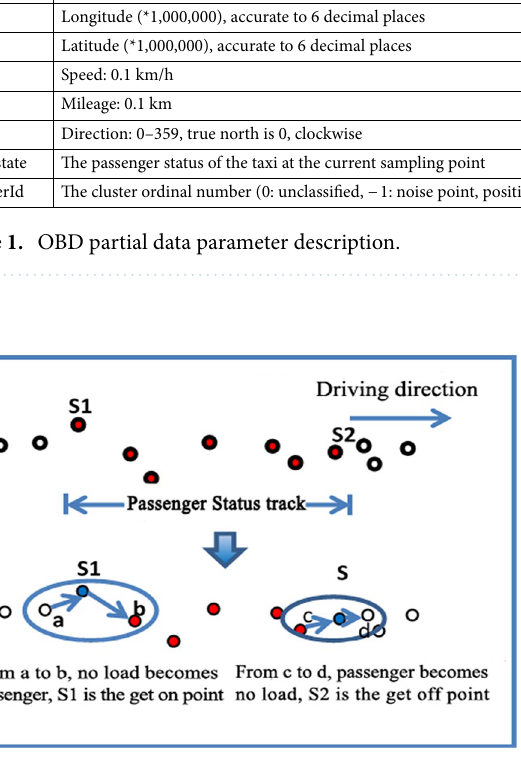
Figure 2. The change status of passengers at data points of getting on and off the